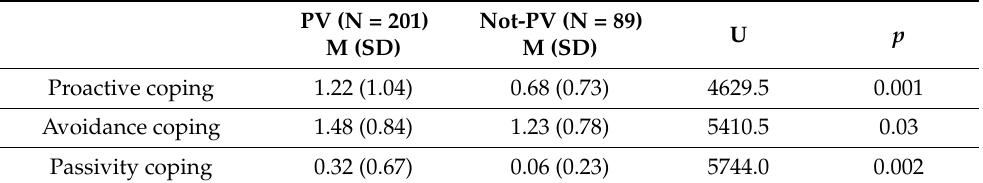
Table 2. Coping strategies: comparison between PV and